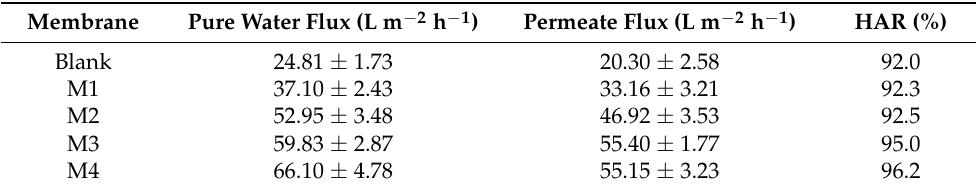
Table 7. Flux and rejection rate of the membrane